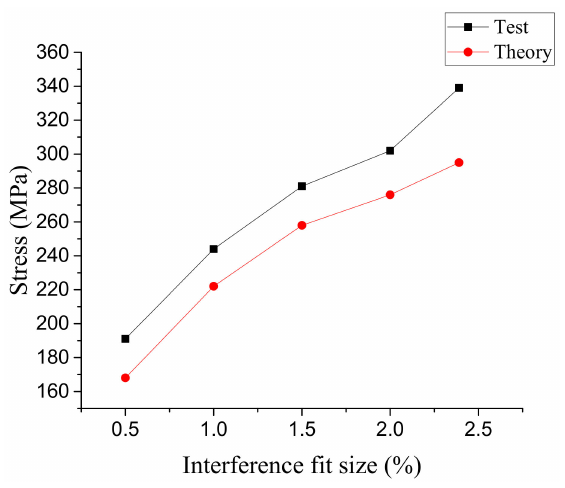
Figure 16. Comparison of variation of interference force with interference fit